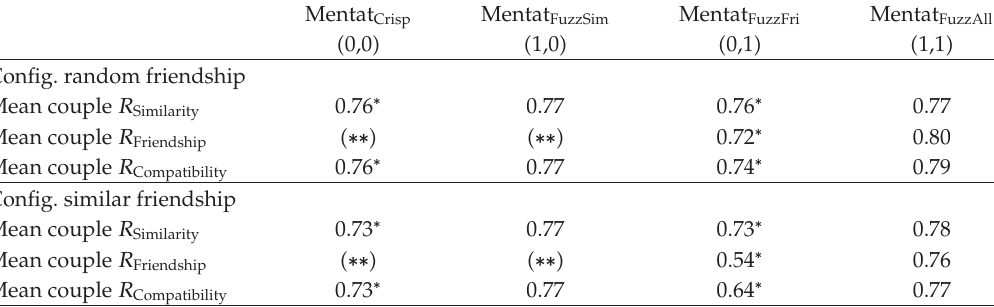
Table 2: Comparison among the di ff erent ABM, in increasing order of